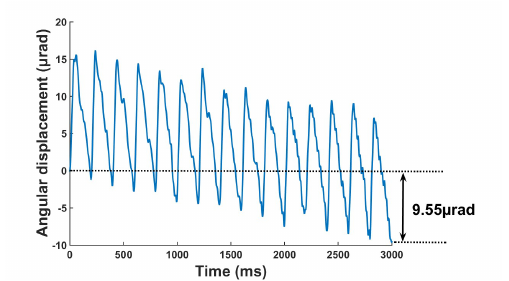
Figure 16. Angular displacement under a driving voltage of 30 V with a preload of 1.01 N and a driving frequency of 5 Hz.